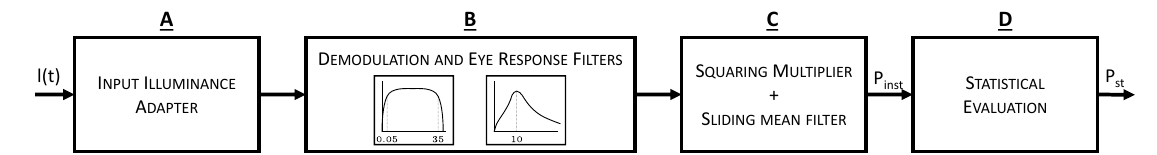
Figure 3. Block diagram of the light flickermeter